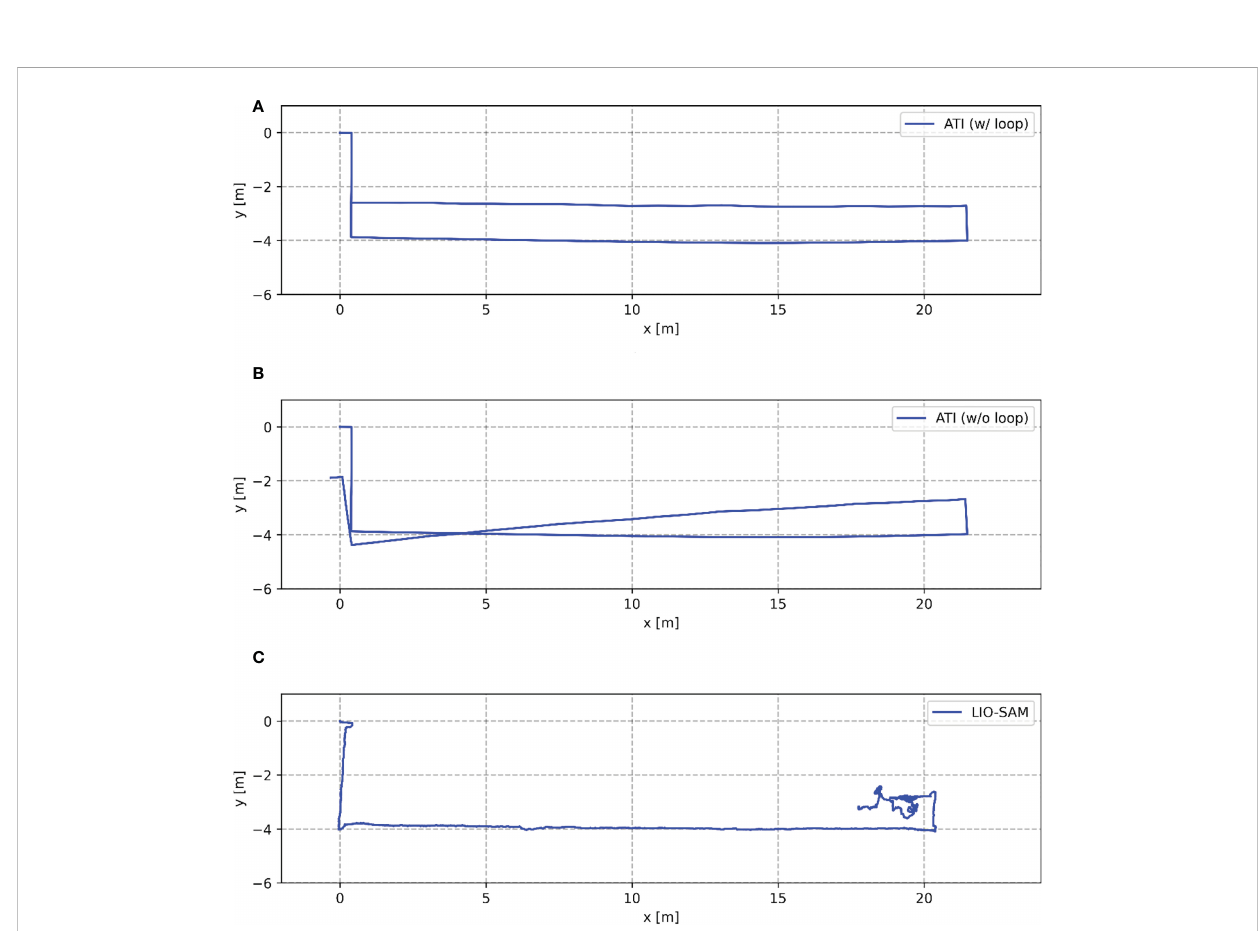
FIGURE 8 Comparison of trajectories obtained by the three mapping approaches running in the experimental area. (A) shows the mapping trajectory processed by the ATI mapping approach with the loop closing optimization. (B) shows the mapping trajectory processed by the ATI mapping approach without the loop closing optimization. (C) shows the mapping trajectory processed by the LIO-SAM algorithm with optimized